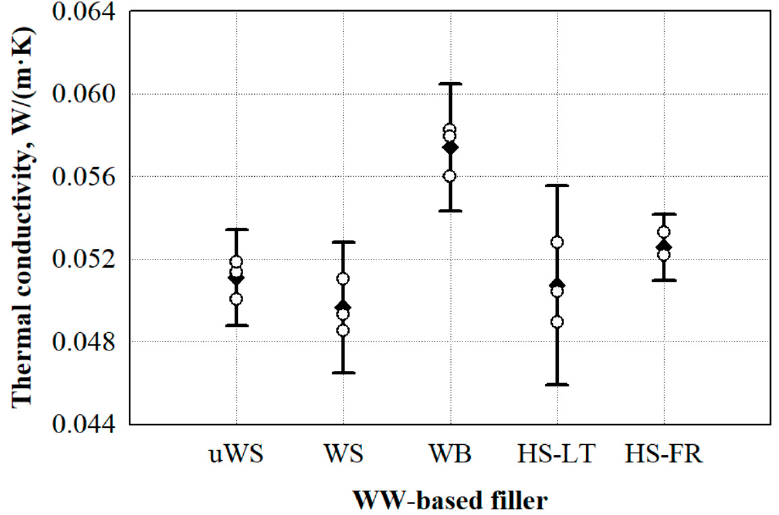
Figure 1. Thermal conductivity variation in regards of the type of WW-based filler: uWS—uncleaned sawdust, WS—cleaned sawdust, WB—wood bark, HS-LT—Lithuanian hemp shivs, HS-FR—French hemp shivs. ο —single values from thermal conductivity measurements; ● —average value from thermal conductivity